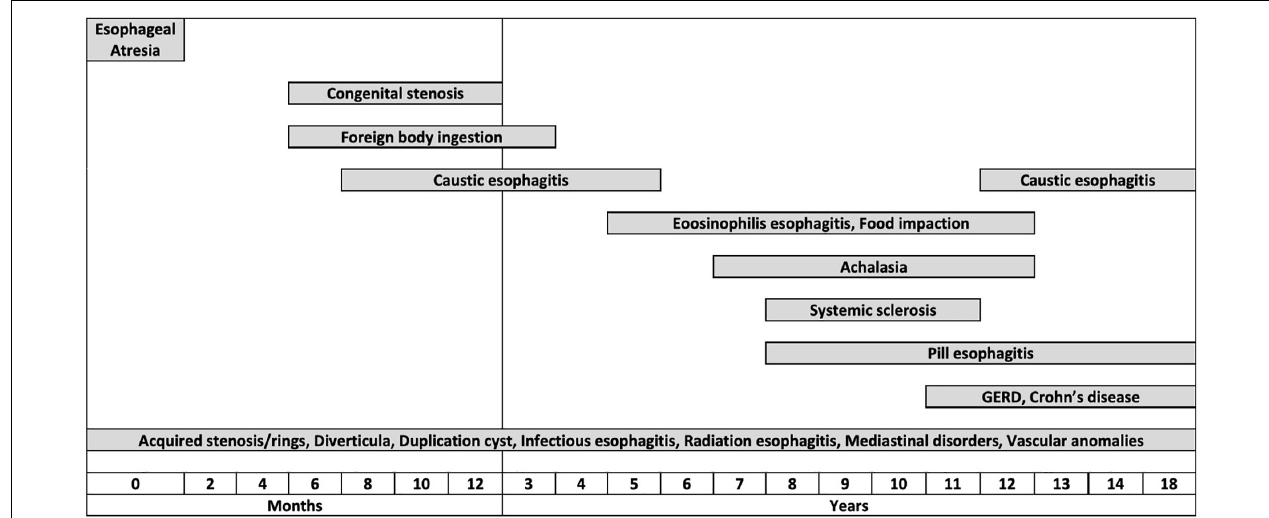
FIGURE 2 | Graphical representation of the distribution of the different esophageal disorders by age